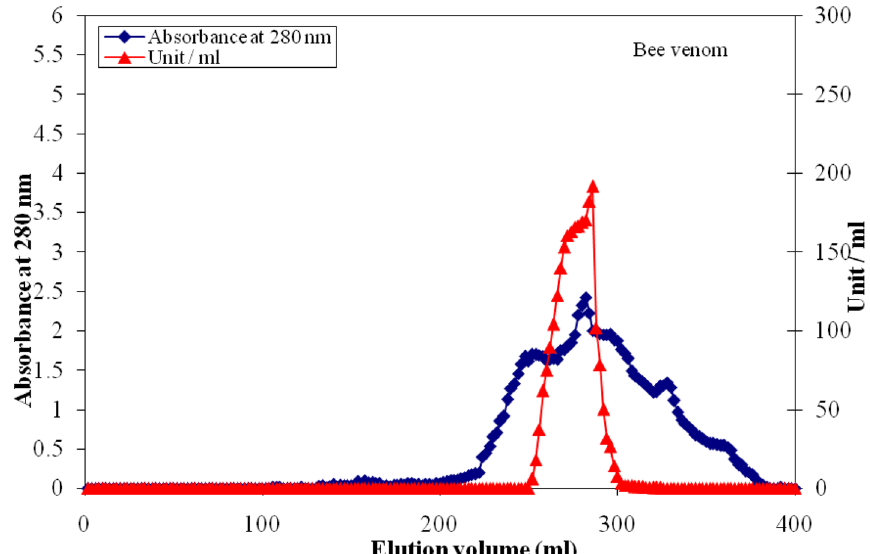
Fig. 2 A chromatographic typical elution profile for the concentrated pooled DEAE‑cellulose fractions containing superoxide dismutase enzyme activity on Sephacryl S‑300 column (142